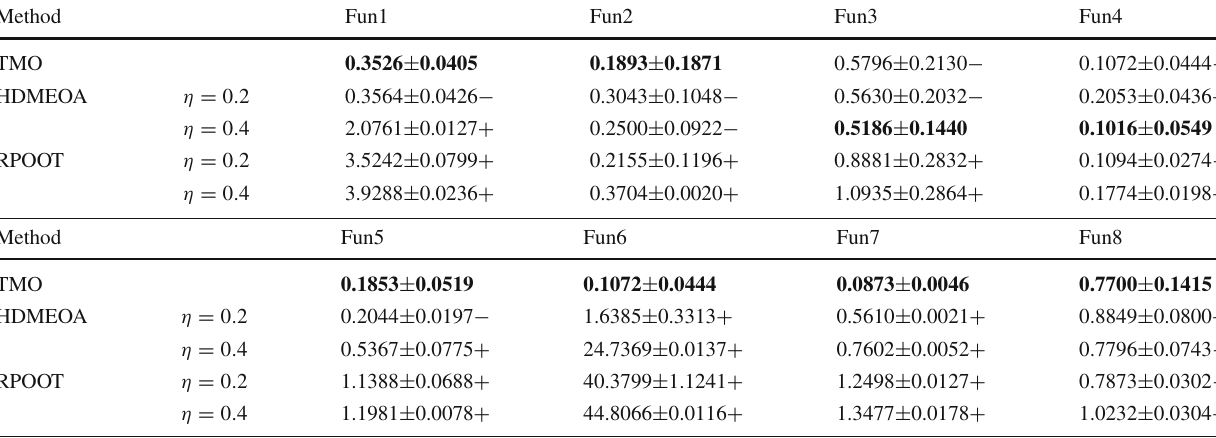
Table 6 MRIGD comparison of three methods under under chaotic environmental changes